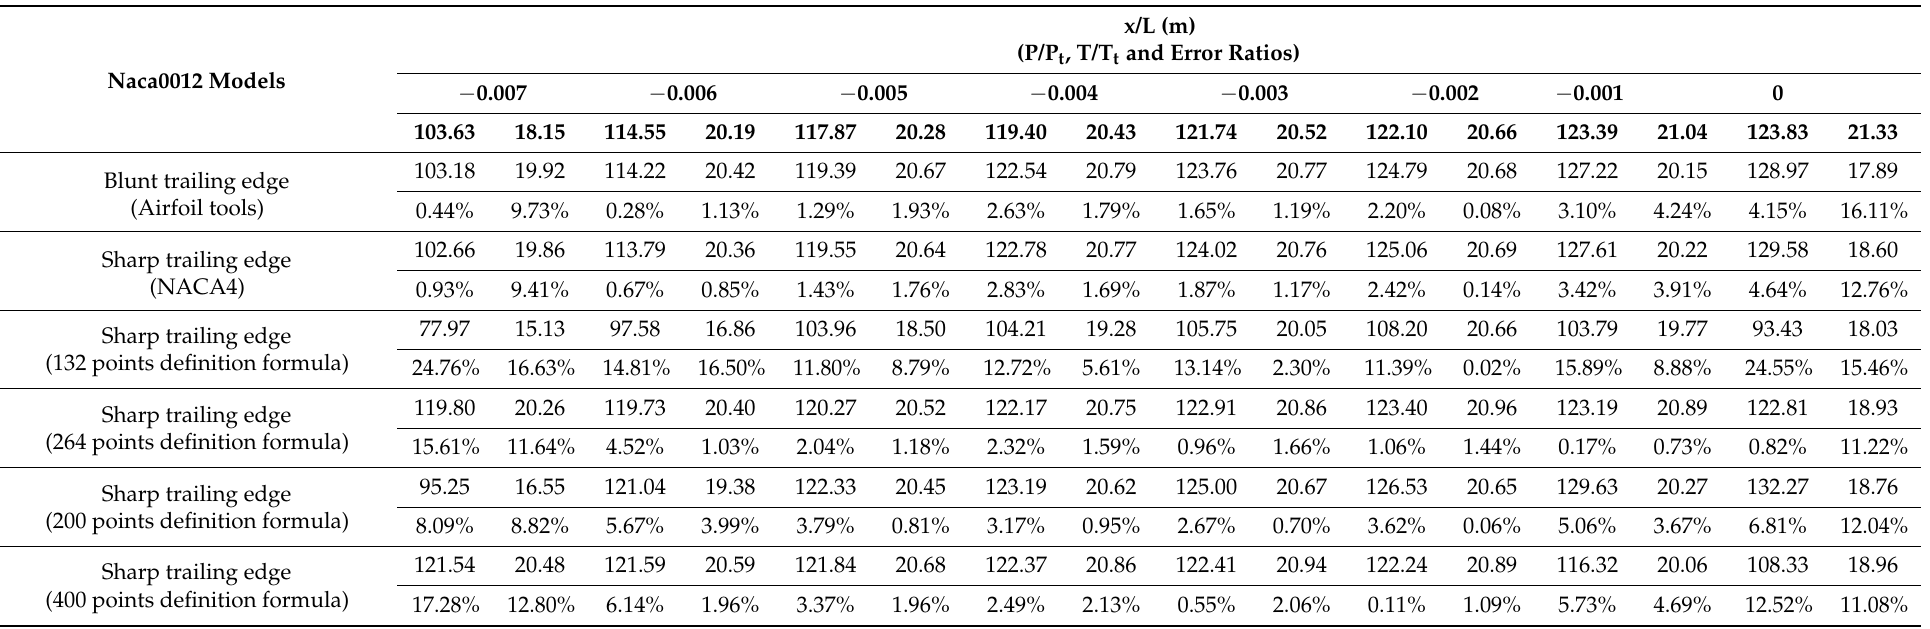
Table 9. Numerical results of P/P t , T/T t and Error Ratios adopting SST k-omega and far-field distance of 12 m.